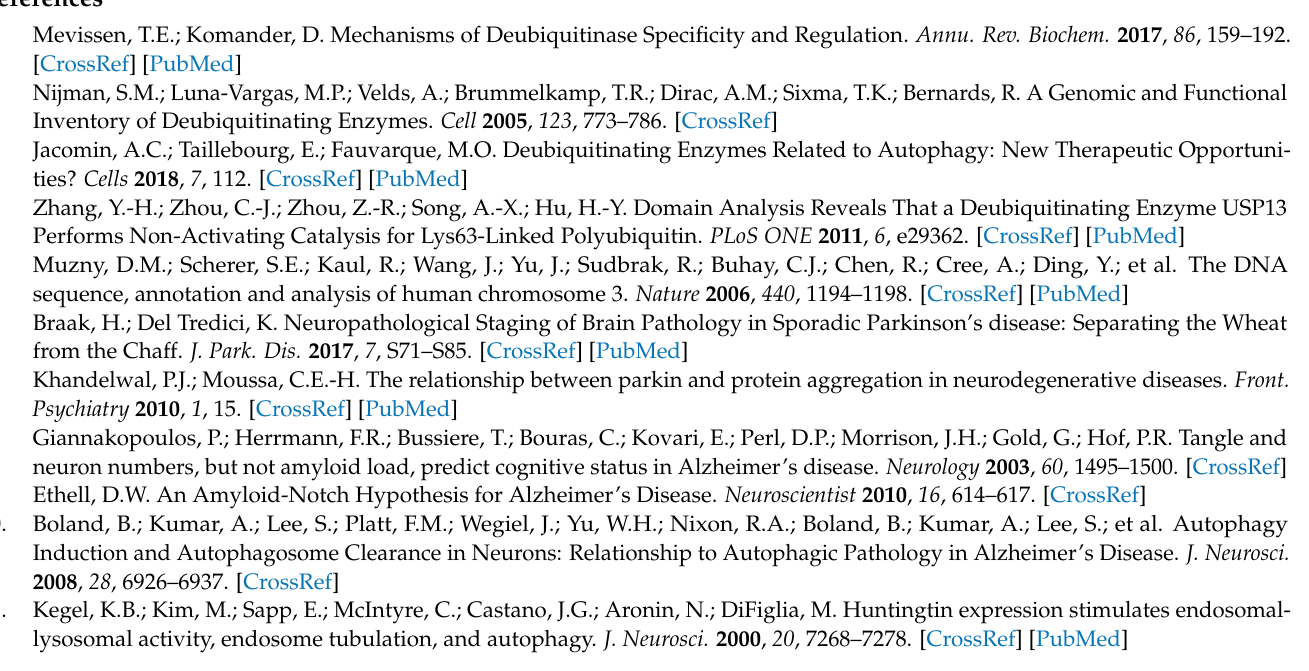
Figure S2: NMR Spectra of CL3-499, CL3-512 and CL3-514, Figure S3: BK50118-C improved cell survivals in TgA53T mice, Figure S4: Synthesis of BK50118-A, BK50118-B and BK50118-C, Figure S5: Synthesis of CL3-499, CL3-512 and